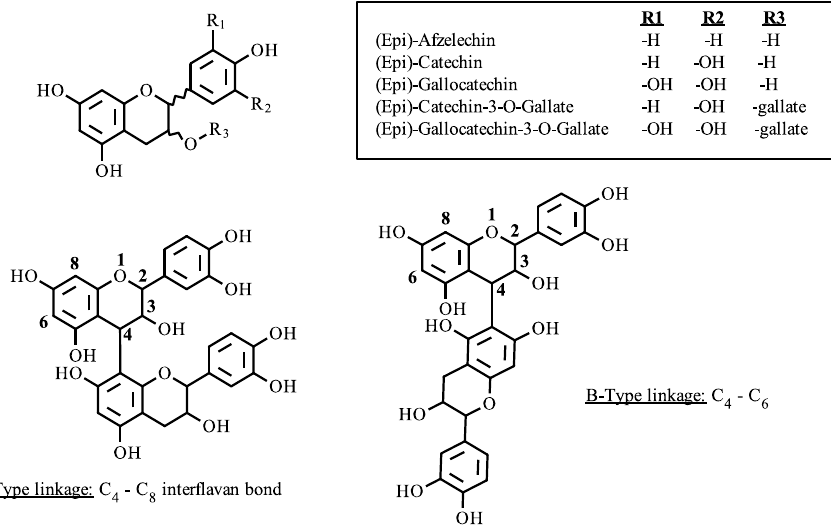
Figure 1. Proanthocyanidin linkages and polymer subunits.